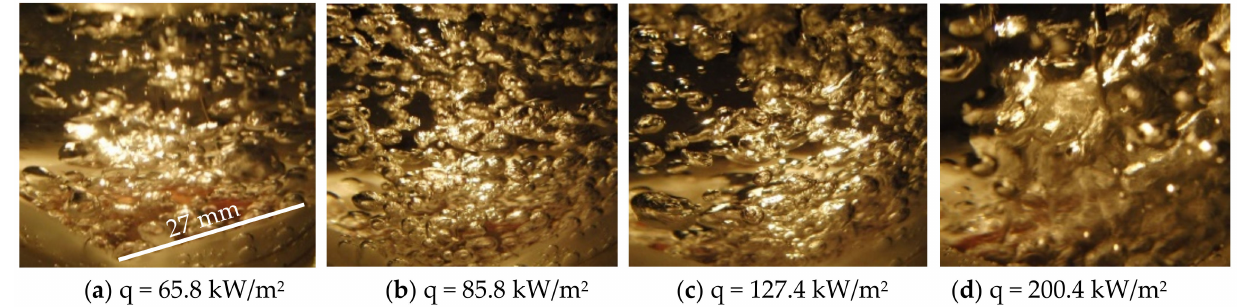
Figure 11. Visualization observation of pool boiling of water on the entire area of the plain smooth surface.